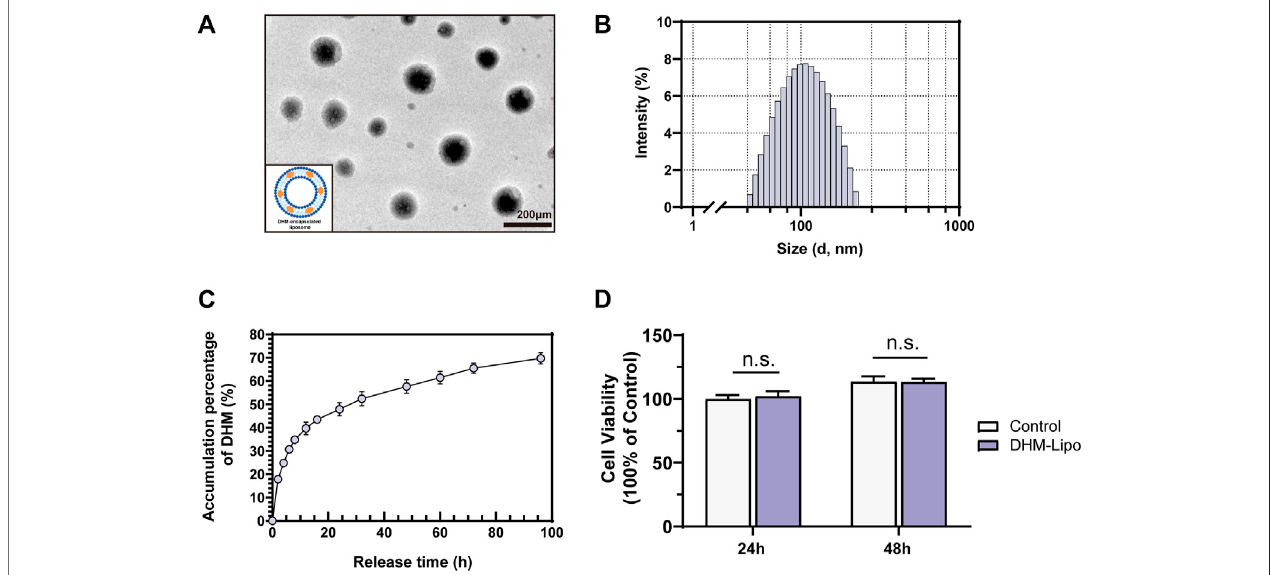
FIGURE 2 | Physical and cytocompatibility characteristics of the DHM-Lipo (A) Micrographs of transmission electron microscopy of the DHM-Lipo (B) Size distributions of the DHM-Lipo (C) Release kinetics of DHM from the DHM-Lipo (D) The cytocompatibility assay of the DHM-Lipo cocultured with RAW264.7 cells was tested by CCK-8. The data are expressed as the mean ± SEM ( n = 3). n. s. p > 0.05, compared to the control group. Scale bar, 200